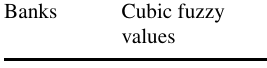
Table 8 The allocation of cubic fuzzy values to the branches of bank B